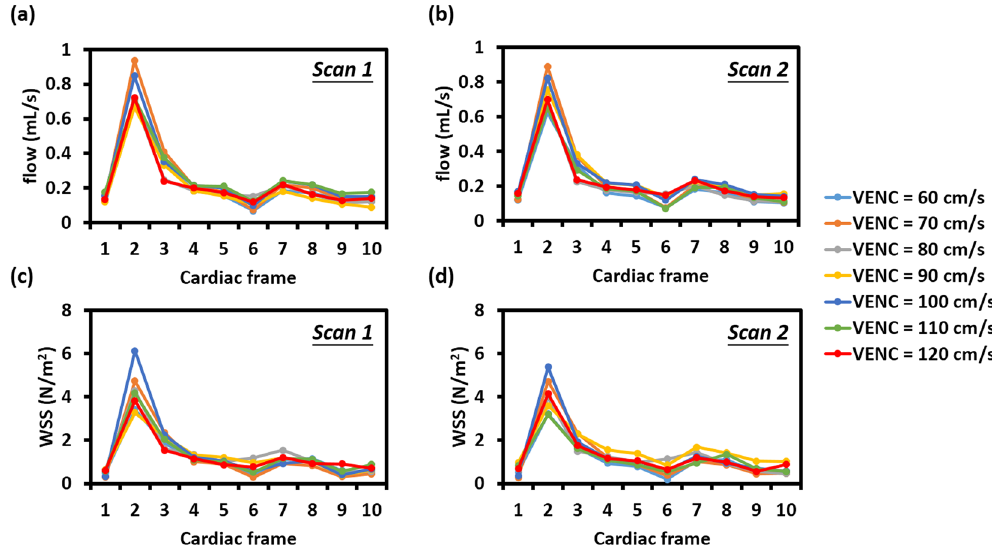
Figure 1. One representative set of time-resolved profiles from different VENC settings for blood flow from ( a ) scan 1 and ( b ) scan 2 and WSS from ( c ) scan 1 and ( d ) scan 2 by the gated PC-MRI strategy. Both blood flow and WSS show repeatable